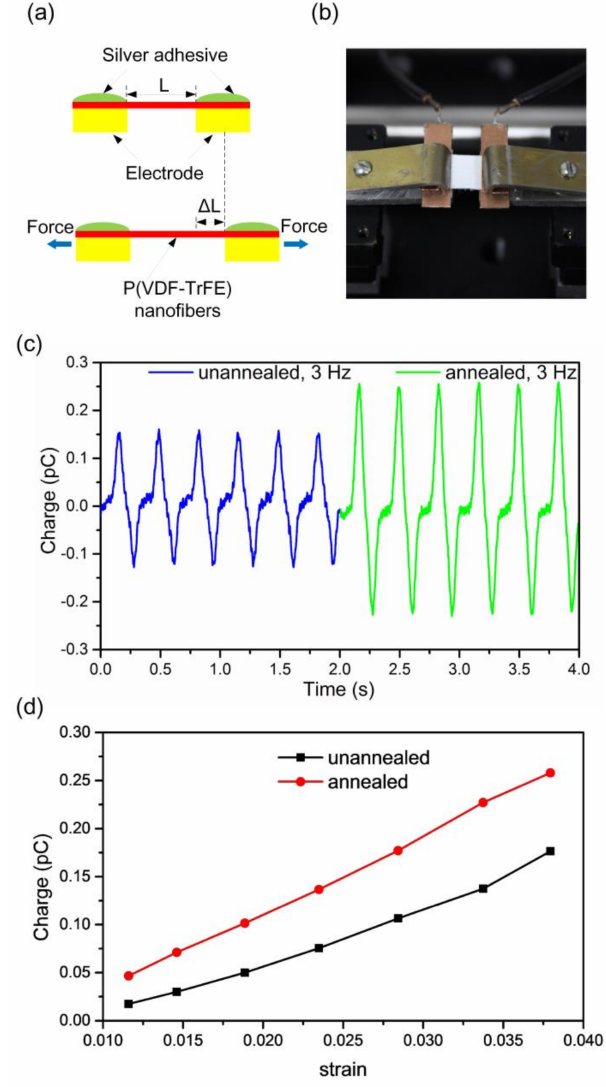
Figure 4. Piezoelectric output measurements in the nanofiber’s longitudinal direction. ( a ) Illustration of the electrical and stretching directions. ( b ) Illustration of the measurement setup. ( c ) Piezoelectric charge output under a tensile strain of 3.8% at 3 Hz for as-spun and annealed P(VDF-TrFE) nanofibers. ( d ) Piezoelectric charge outputs as functions of amplitude of strain for as-spun and annealed P(VDF-TrFE)